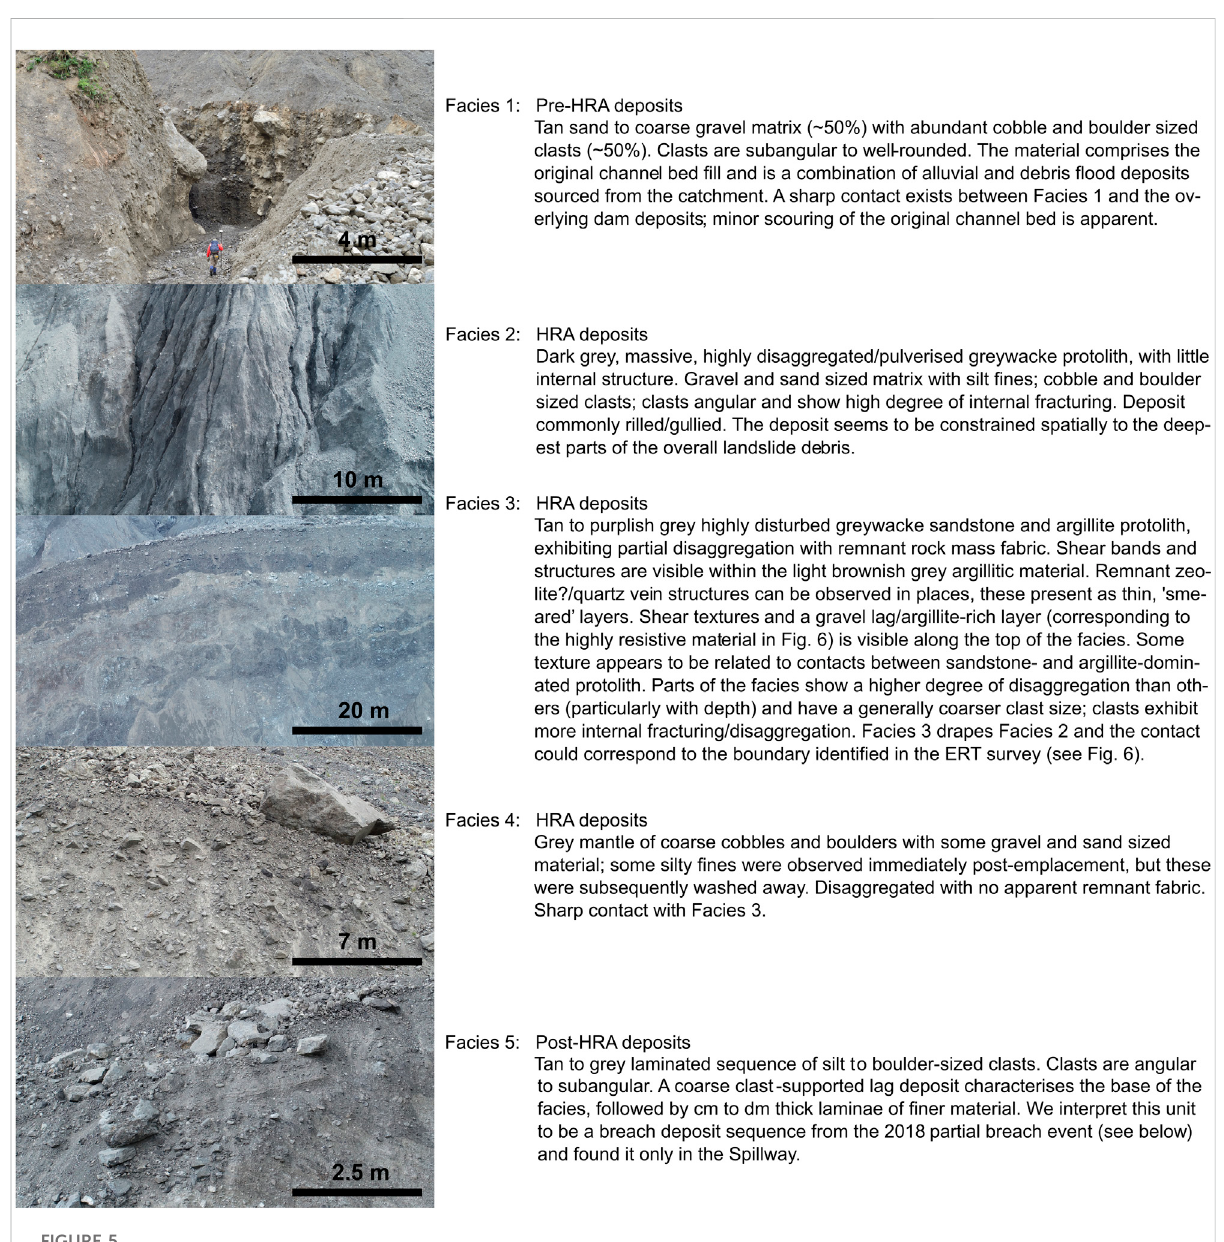
FIGURE 5 Examples and descriptions of facies identi fi ed from dam face mapping of the HRA